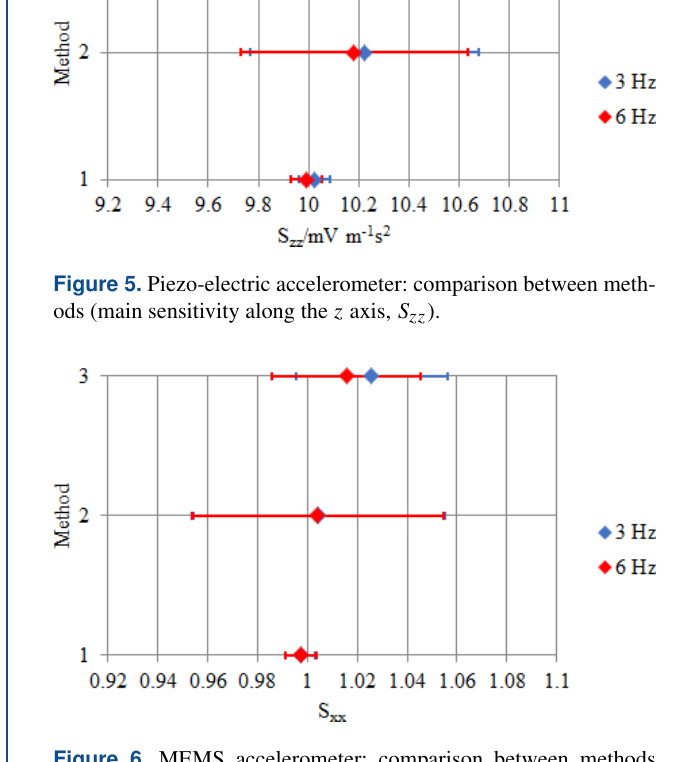
Figure 8. MEMS accelerometer: comparison between methods (main sensitivity along the z axis, S zz